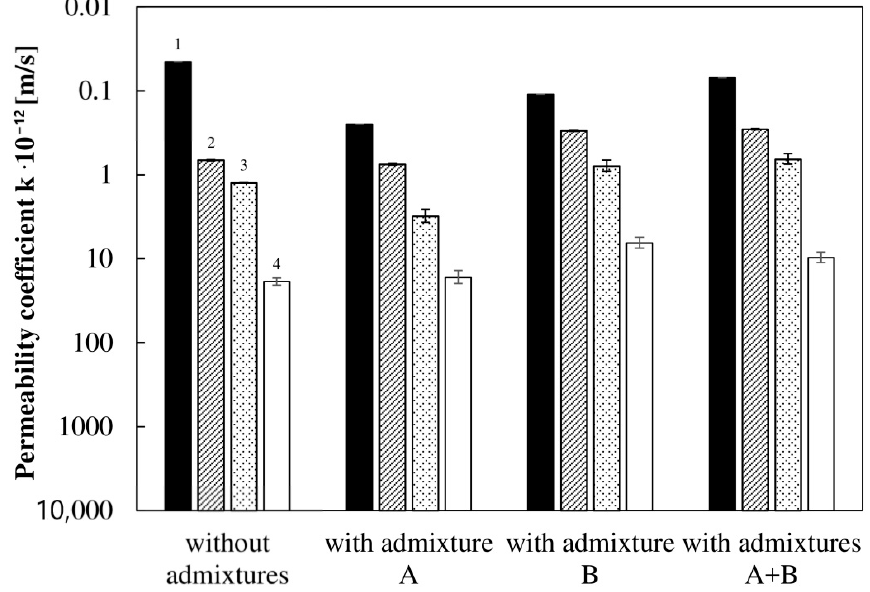
Figure 7. Comparison of the permeability of the concretes with different admixtures obtained from two methods: (1) the flow pump test method at a constant hydraulic head and (2–4) the depth of water penetration test method—where 2 is corrected by the content of pores filled with water, 3 is corrected by the apparent air content, and 4 is corrected by the relationship between the average and maximal penetration depths. Error bars indicate the standard deviation of the experiments (2 σ ).